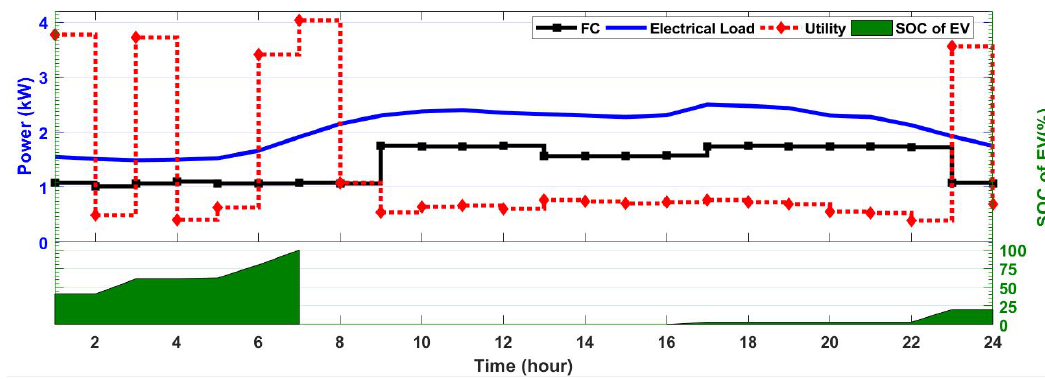
Figure 10. Case 5: Results of the system with scheduling of EV.